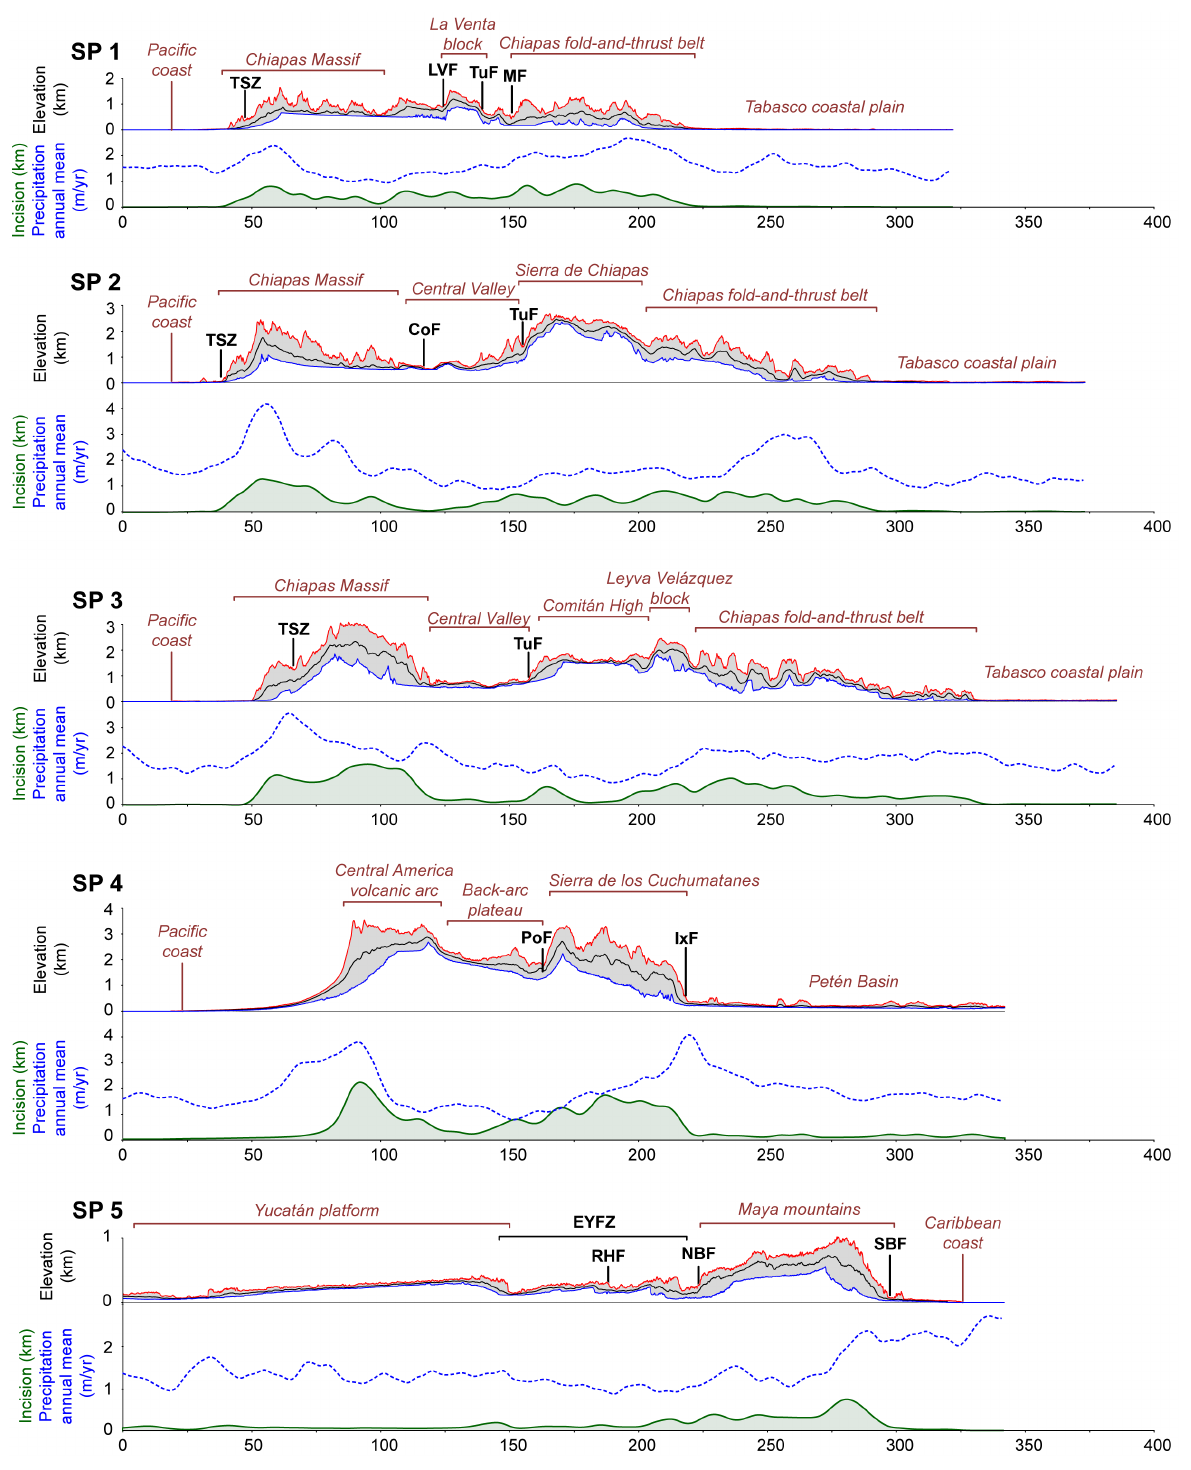
Figure 6. Swath profiles across the Sierra Madre de Chiapas, volcanic arc, and Maya Mountains. Upper plots: topographic profiles (swath width is 20km). Vertical exaggeration is 10 for profiles 1–4 and 25 for profile 5. Red, black and blue curves represent the maximum, mean and minimum elevations, respectively. Lower plots: green lines represent the local incision in km (subtraction of minimum and maximum elevations). Blue dashed lines represent annual averaged precipitation (derived from TRMM data) in myr − 1 . See Fig. 2 for